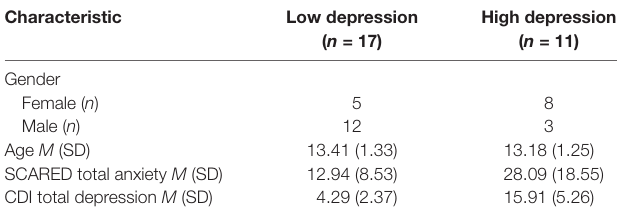
TABLE 2 | Characteristics of low and high depression groups used for illustrative purposes in decomposition analyses.